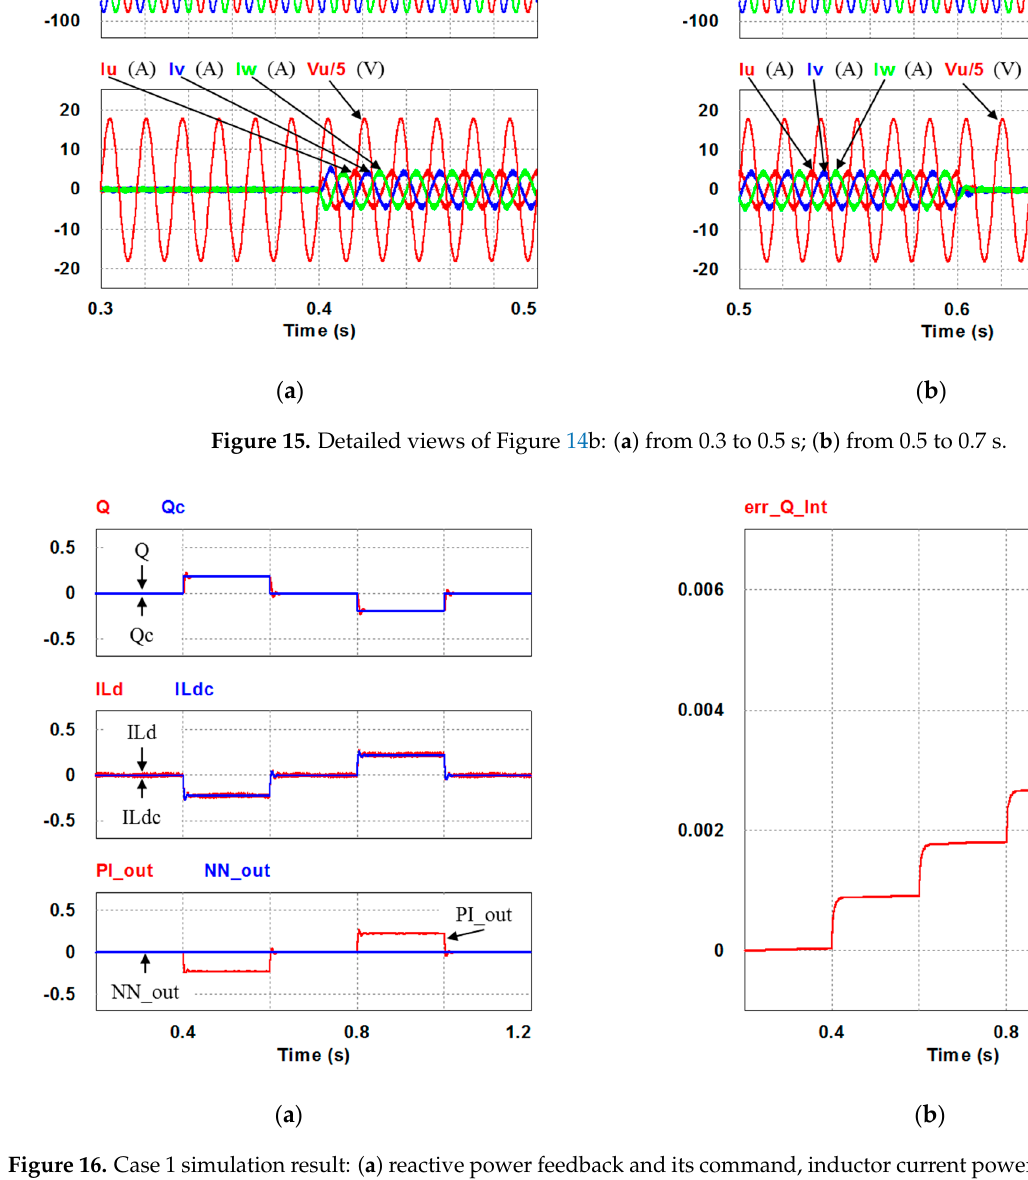
( b ) Figure 17. Detailed views of Figure 16 ( a ): ( a ) from 0.3 to 0.5 s; ( b ) from 0.5 to 0.7 s. 4.2. Results of Simulation Case 2: PI Controller + RBFNN Controller In this case, the PI controller in the last subsection is joined with the RBFNN control- ler in the reactive power control loop. Simulation results are presented in Figures 18–20b. Figures 18 and 19 show that the phases and amplitudes of three-phase currents are well